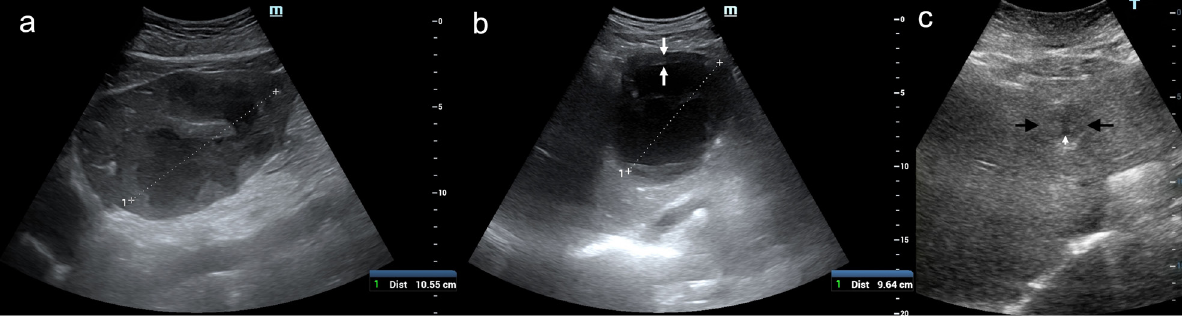
Figure 1. US B-mode patterns of PLA. (a) A large (11 cm) heterogeneous solid mass with fluid levels occupies the left liver lobe; (b) cystic-like PLA: a thick solid capsule (between white arrows) encircles a large colliquated cavity of 9.6 cm; (c) tumor-like PLA: a 4-cm poorly visible, hypoechoic lesion (between black arrows) with a small, central liquid area (black